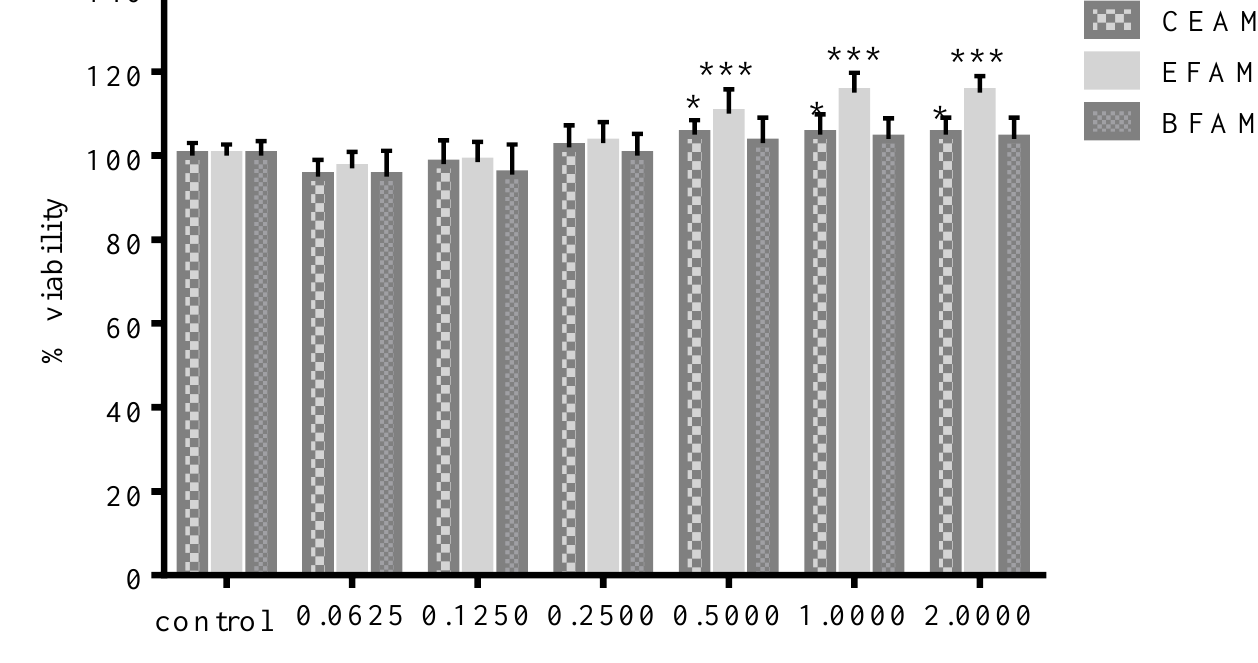
Figure 2. Viability of the oral epithelial cell OEC treated with CEAM, EFAM, and BFAM for 24 h. Data show the percentage of OEC viability at each concentration ( n = 6). * p < 0.05, ** p < 0.01 *** p < 0.001 using One-way ANOVA followed by a Schiff multiple range test. Results are shown as mean ± S.D.